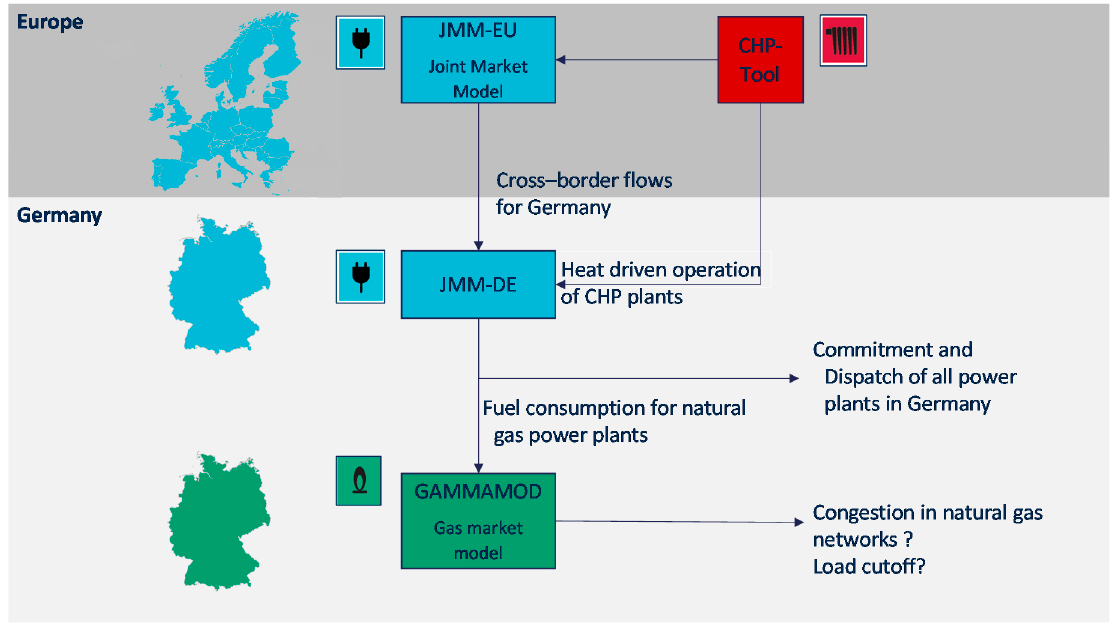
Figure 2. Overview of coupling JMM and GAMAMOD. Source: authors’ illustration.